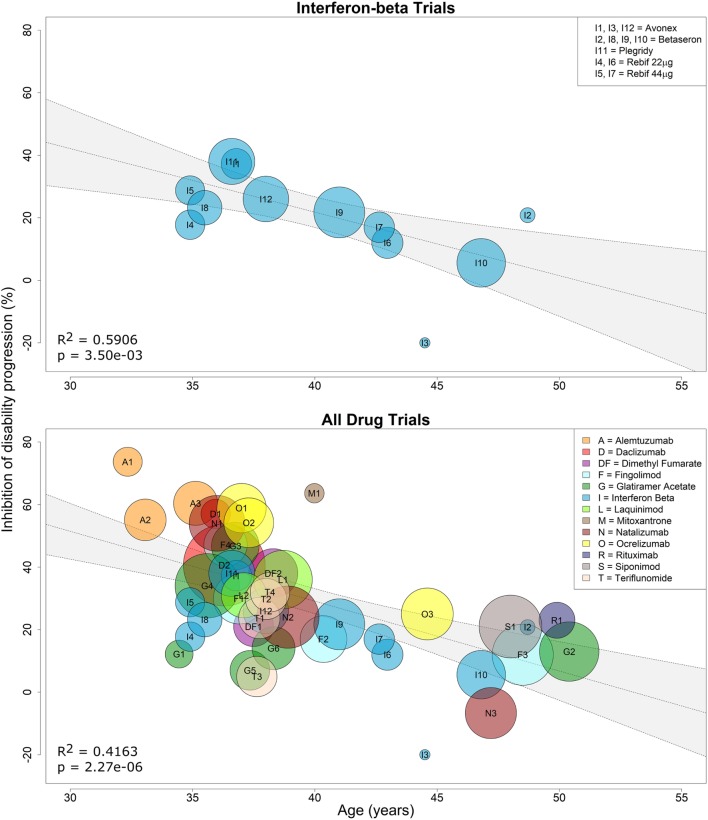
Efficacy of interferon-beta preparations and all immunomodulatory drugs on sustained disability progression decreases with age. Linear regression of the efficacy of all interferon-beta formulations against placebo on sustained disability progression as a function of age (top panel). Each contributing trial has assigned weight proportional to the number of subjects and trial duration (see Eq. 2 in Materials and Methods). The resulting linear regression was used to estimate percent inhibition of disability progression (%IDP) of interferon beta against placebo at baseline age (see Eq. 1). This estimate was then used to recalculate %IDP for all immunomodulatory drugs against placebo as a function of age (see Eq. 7). Linear regression of the efficacy of all drugs against placebo on sustained disability progression as a function of age (bottom panel). Again, each contributing trial has assigned weight proportional to the number of subjects and trial duration. The coefficient of determination (R2) and p-values are indicated in the respective plots, while the inset legends denote the trial indices.